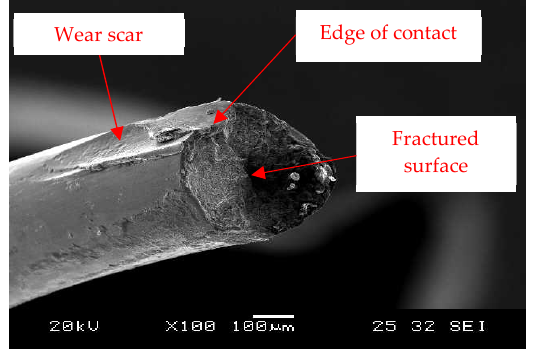
Figure 1. SEM micrograph showing the fracture of the wire at the edge of the wear scar produced by a combined fretting wear and fretting fatigue phenomena.